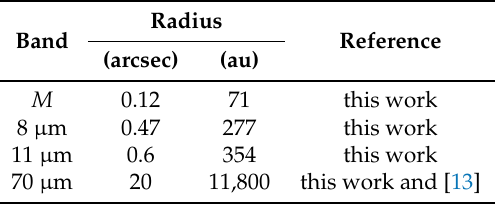
Table 1. Upper-limits for the circumstellar envelope sizes for an adopted distance of 590